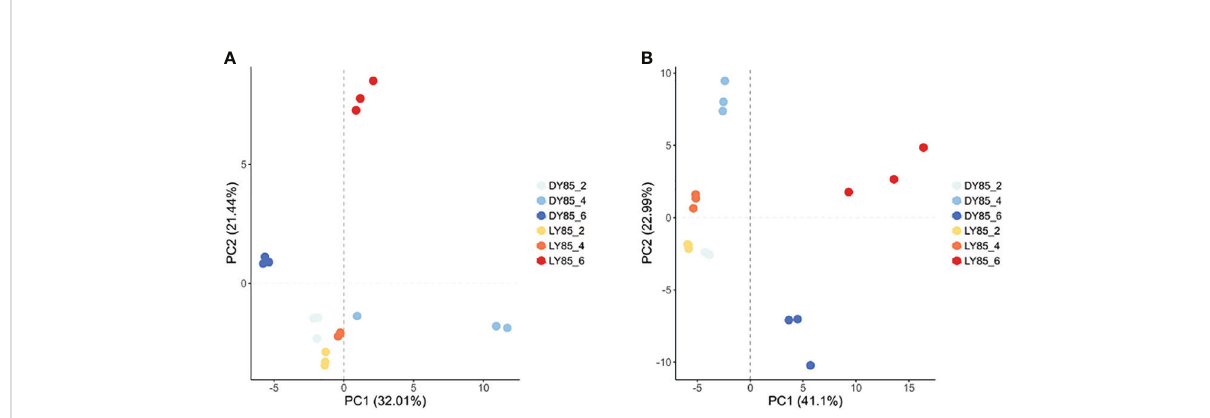
FIGURE 7 PCA plots of light-regulated germination and post-germination development. They were plotted with DEG (A) and DEP (B) , respectively. The consistency and diversity of the samples were observed through PCA. Each point in the fi gure represents a repetition, and different colors represent the difference of light treatment or development stage.